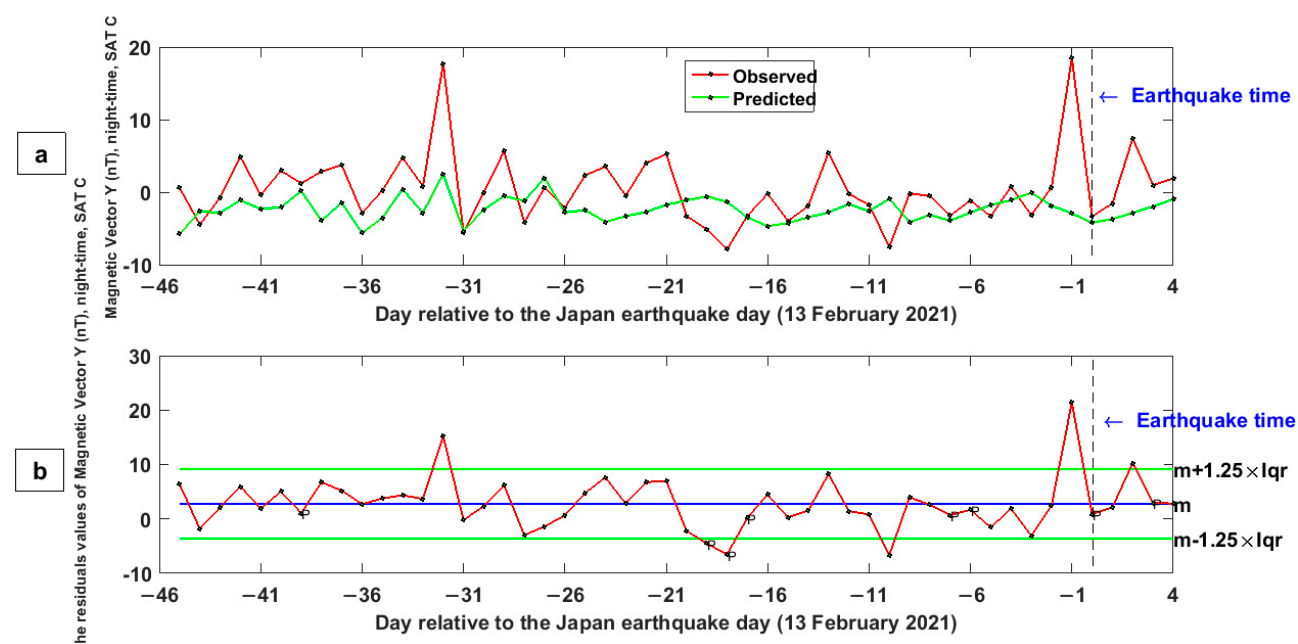
Figure 11. ( a ) Variations of the observed (red curve) and the predicted (green curve) night-time Y magnetic field measured by Swarm C and obtained by the LSTM method during testing day. ( b ) Variations of the differences between the observed and the predicted values of Y magnetic field obtained by the LSTM method during testing days. The geomagnetically “perturbed” days are highlighted by a “P”.